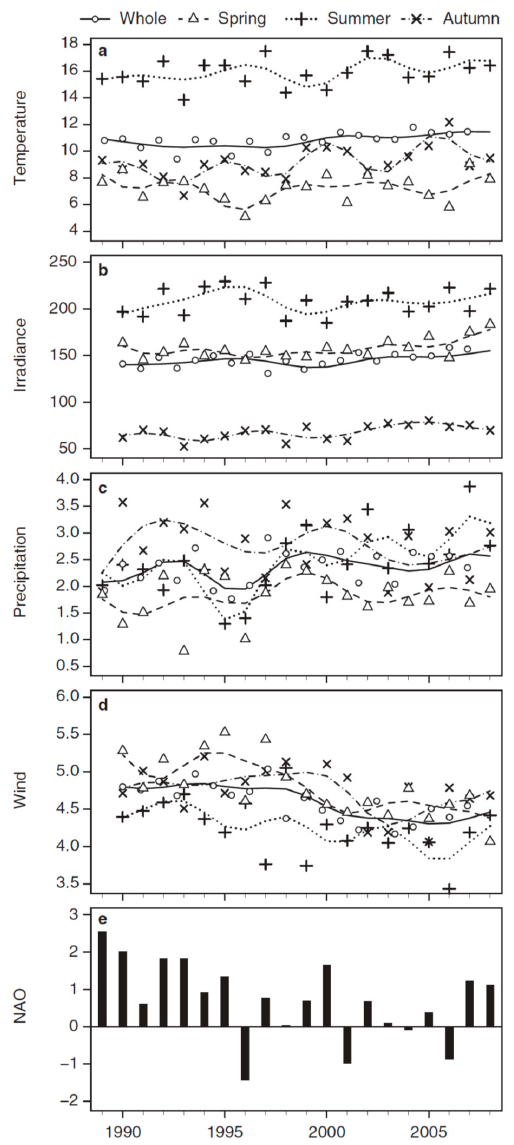
Figure 2. Two ‐ decade trends in temperature ( a , °C), solar irradiation ( b , W ∙ m − 2 ), precipitation ( c , mm) and wind speed ( d , m ∙ s − 1 ) averaged over 17 lakes, as well as the North Atlantic Oscillation Index ( e ). Yearly means were calculated for the whole year excluding winter and separately for spring, summer and autumn. Generalised additive model annual smoothers [53] were overlaid to each dataset to summarise trends ( P < 0.05 for all).